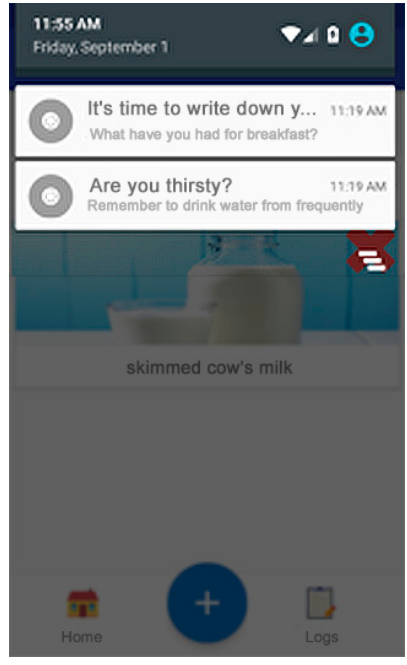
Figure 10. Notification reminder system.